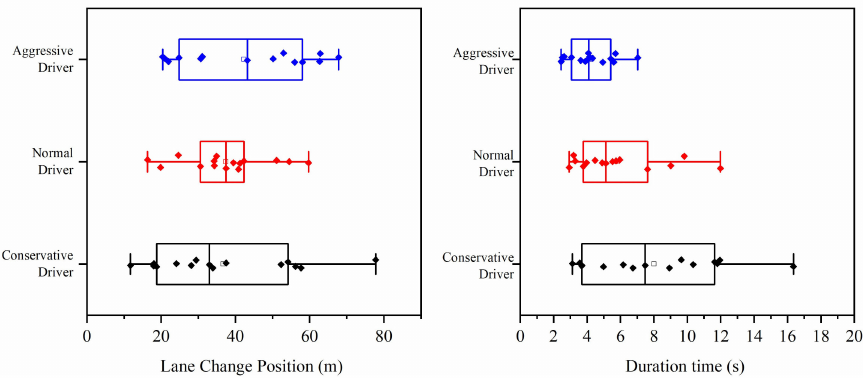
Figure 8. Lane-change position and duration time for three types of driver.